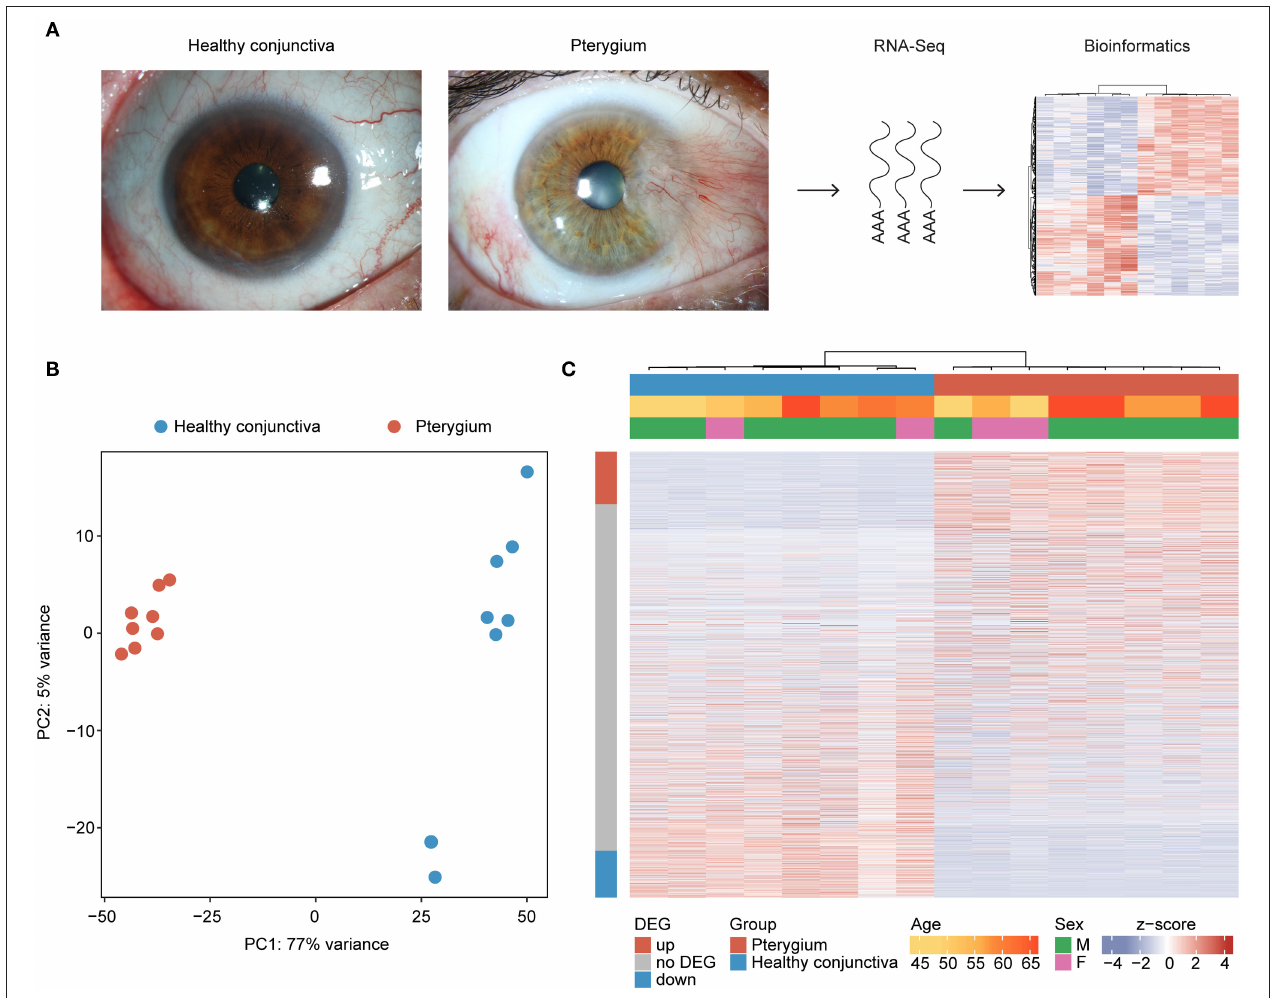
FIGURE 1 | Unsupervised cluster analysis of eight pterygium and eight healthy conjunctival specimens. (A) Representative photographs of pterygium and healthy conjunctiva as well as an overview of the study design. (B) Principal component analysis. (C) Heatmap visualizing the expression of 15.984 genes with at least one read in eight pterygium and eight healthy conjunctival specimens. Basic demographic and clinical data are shown above. Each column represents one sample (red: pterygium, blue: healthy conjunctiva) and each row one expressed gene. The rows are ordered according to the log2 fold change between both groups, placing the upregulated genes in pterygia at the top (see row annotation red) and the downregulated genes at the bottom of the heatmap (see row annotation blue). Unsupervised clustering was performed for the columns (see dendrogram). The z-score represents a gene’s expression in relation to its mean expression by standard deviation units (red: upregulation, blue: downregulation). DEG, differentially expressed